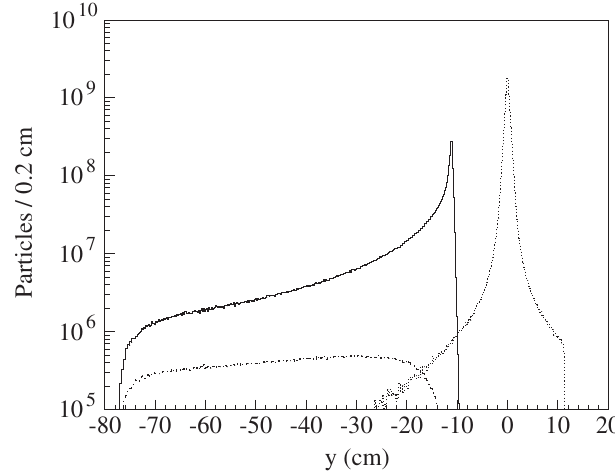
FIG. 18. Vertical profiles for the charged beam (full line), including the particles of the coherent pairs with the right-sign charge (dashed line), and for the beamstrahlung photons (dotted line), as obtained at the end of the post-collision line, 150 m downstream of the interaction